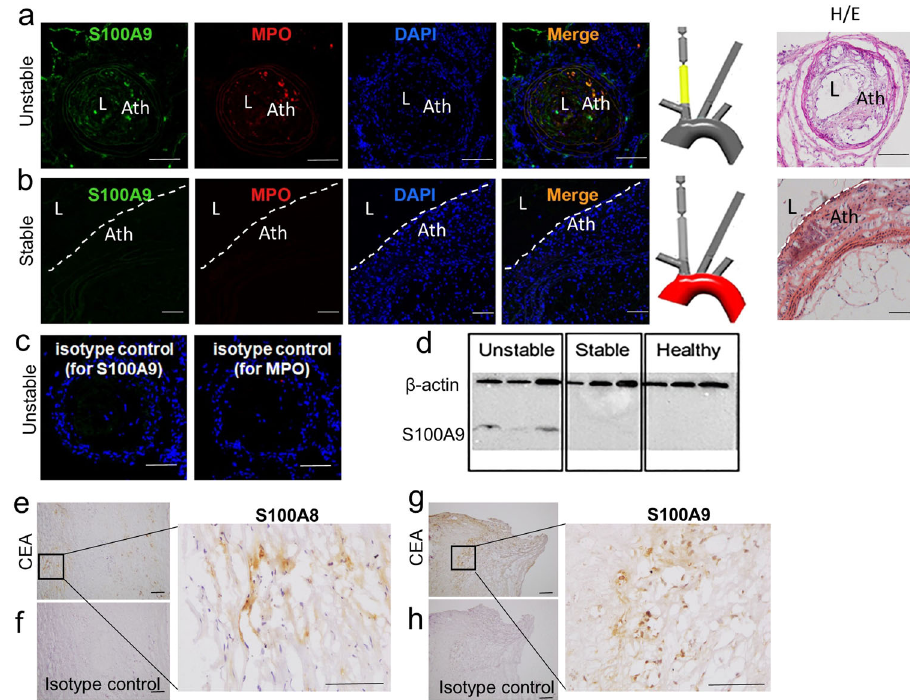
Fig. 4 Validation of S100A8, S100A9 protein expression in TS plaques and human carotid plaques. a S100A9, MPO, and DAPI immuno fl uorescence staining in unstable TS mice plaques ( n = 10) and b stable plaques ( n = 10). As a negative control, c IgG Isotype control antibodies for S100A9 and MPO were deployed. d Western blots were performed in three TS mice, and each artery segment was collected for protein identi fi cation. S100A9 is only found in the segments that are unstable. e S100A8 and g S100A9 immunohistochemistry in human carotid plaques ( n = 14). As a negative control, IgG Isotype control antibodies for f S100A8 and h S100A9 were deployed. Bars indicate 100 μ m. H/E: Hematoxylin and eosin, L: Lumen, Ath: Atherosclerosis. Dashed lines indicate